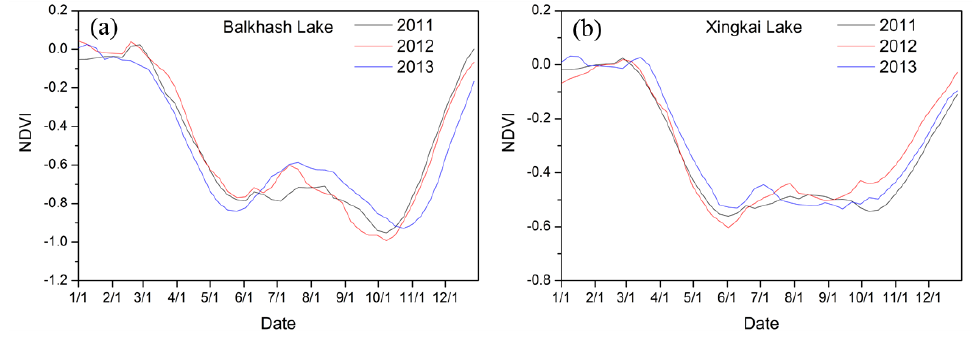
Figure 2. Time series curves of the normalized difference vegetation index across different years for Balkhash Lake, Kazakhstan ( a ) and Xingkai Lake, China ( b ).